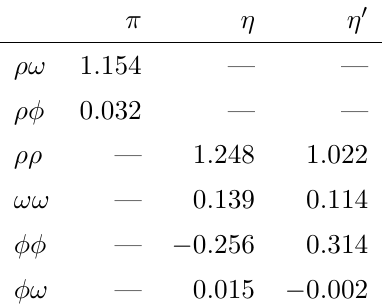
with P = (cid:25); (cid:17); (cid:17) 0 and V 1 V 2